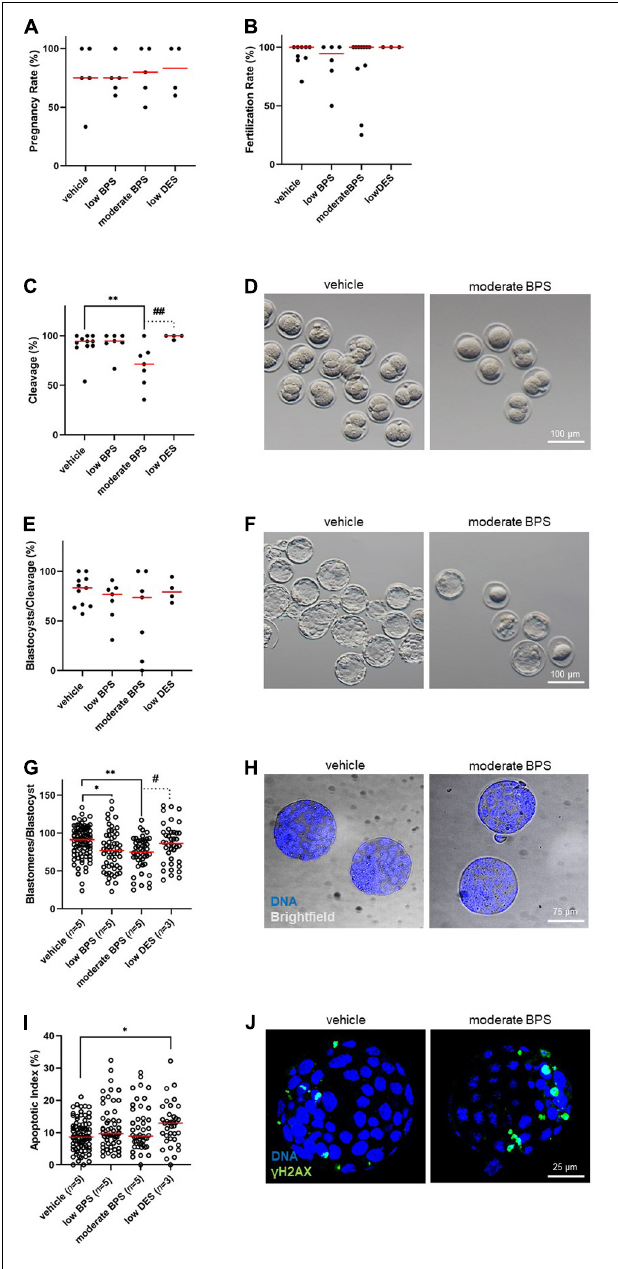
FIGURE 5 | Development of the embryos is compromised by male bisphenol exposure during the nursing period. (A) Pregnancy rate (%) of females mated by bisphenol-exposed males of control, low bisphenol S (BPS), moderate BPS, and low diethylstilbestrol (DES) groups. Dots represent the values belonging to individual males, and the red line shows the median. (B) Fertilization rate (%) of males, expressed as a portion of fertilized oocytes, while females are recognized as pregnant and flushed. Dots represent values belonging to individual males, and the red line shows the median. (C) Cleavage of zygotes after BPS-exposed males (%) in the control, low BPS, moderate BPS, and low DES groups. Dots represent values belonging to individual males, and the red line shows the median. (D) Representative pictures of cleavage of zygotes on behalf of control and moderate-BPS-exposed males. (E) Blastocyst rate (%), expressed as the (Continued)